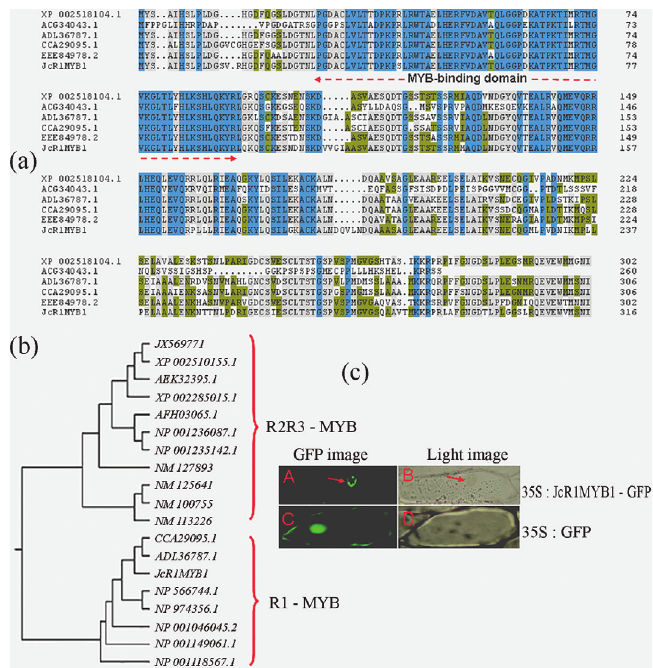
Figure1 -Characterizationof JcR1MYB1. (A)AminoacidsequencealignmentofJcR1MYB1R1andothersingleMYB-likedomainproteins.Accession numbers are as follows: Ricinus communis , XP005518104.1; Zea mays , ACG34043.1; Malus domestica , ADL36787.1; Rosa rugosa , CCA29095.1; Populus trichocarpa , EEE84978.2. Identical amino acid residues are colored. (B) Phylogenetic analysis of JcR1MYB1. The phylogenic tree was con- structed with the DNAMAN program using the deduced amino acid sequence. Accession numbers are as follows: Arabidopsis thaliana, NP_566744.1; NP_974356.1; NP_001118567.1; NM_127893;NM_100755; NM_113226; Oryza sativa , NP_001046045.2; Zea mays , NP_001149061.1; Jatropha curcas , JX569771.1; Ricinus communis ,XP_002510155.1; Citrus sinensis , AEK32395.1; Vitis vinifera , XP_002285015.1; Epimedium sagittatum , AFH03065.1; Glycine max , NP_001238087.1; NP_001235142.1; Malus domestica , ADL36787.1; Rosa rugosa , CCA29095.1. (C) Nuclear localization of the JcR1MYB1 -GFP fusion protein in onion epidermal cells. The GFP fluorescence images (GFP image and light image) of onion epidermal cells were compared to show the subcellular localization of 35S-JcR1MYB1-GFP (A) and of 35S-GFP